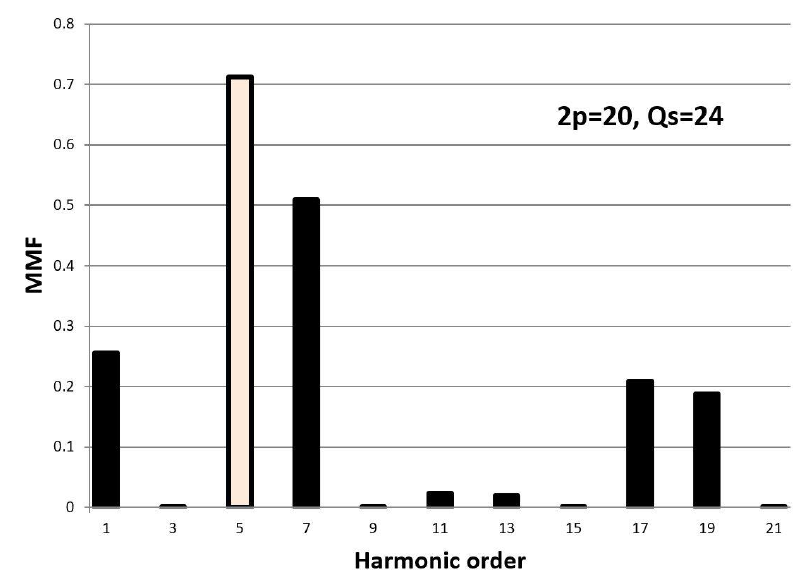
Figure 2. Distribution of the magnetomotive force MMF for a motor with a number of poles 2p = 20 and number of stator slots Q s = 24.